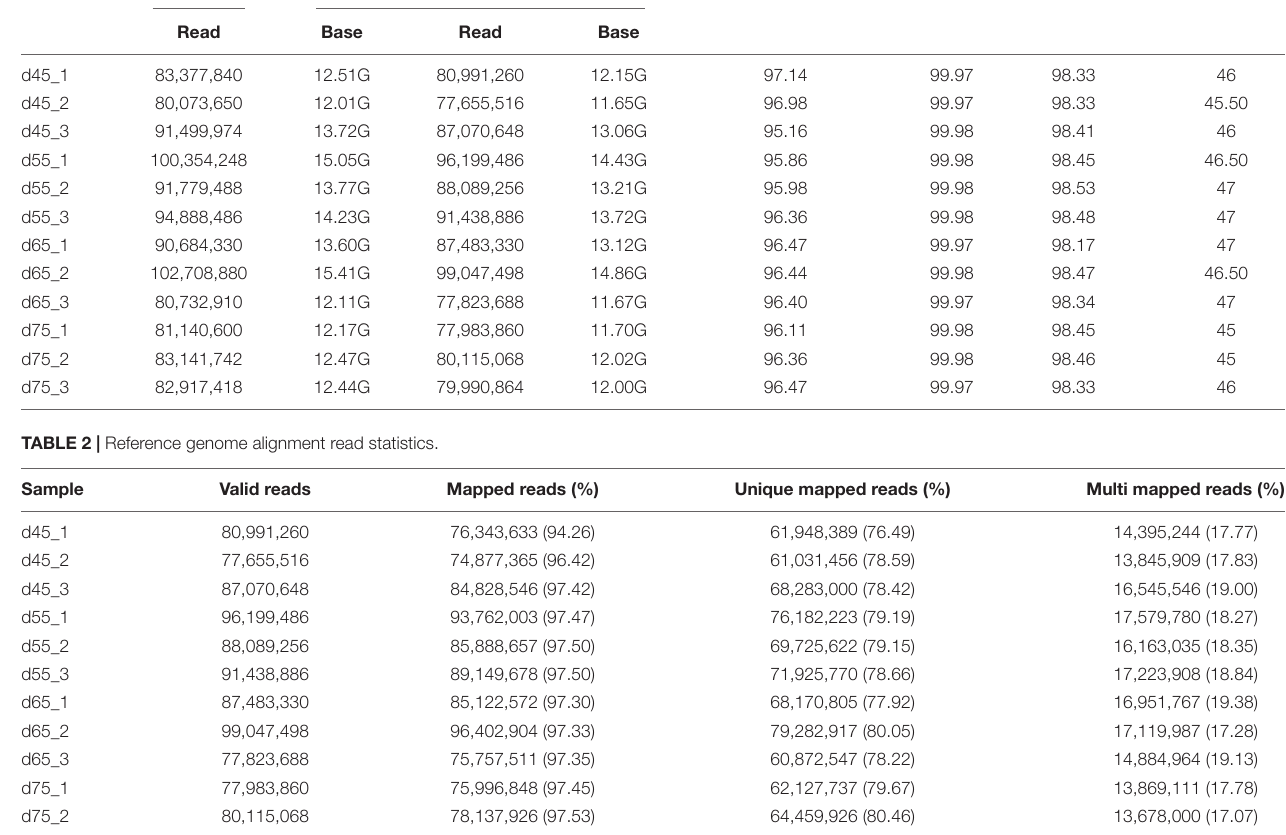
( Figure 4 ). By further exploring the law of differential expression of circRNA, it was found that the differential expression of circRNA of d65vsd55 was the greatest, while the differential expression of circRNA of d75vsd65 was the lowest ( Figure 4 and Supplementary Figure 2